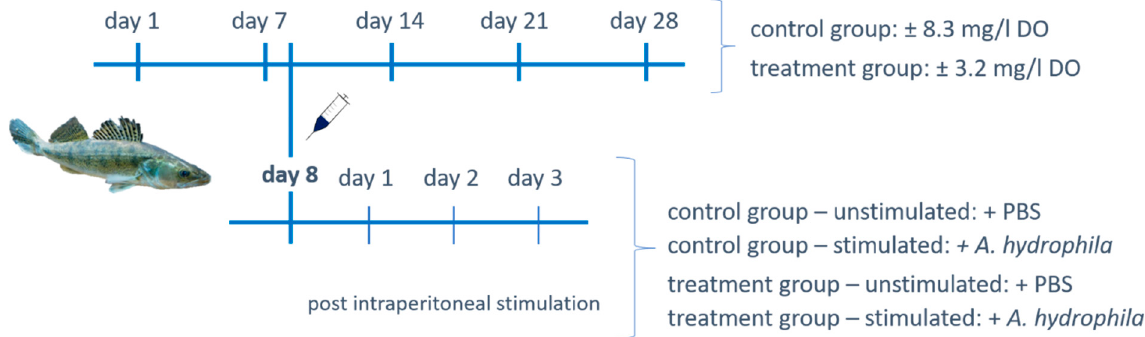
Figure 1. Outline of the experimental design. The 98 adult pikeperch were kept either under normoxic water conditions (±8.3 mg/L dissolved oxygen (DO) level) or low DO saturation (±3.2 mg/L DO level) for up to 28 days. Peripheral blood, head kidney (HK) and liver tissues were sampled from five fish of both groups. Additionally, at day 8 of the experiment, 48 fish were intraperitoneally injected with either 1 × 10 7 inactivated Aeromonas hydrophila cells in 100 µL sterile phosphate-buffered saline solution (PBS) or exclusively 100 µL PBS. At three following days, peritoneal leukocytes, peripheral blood, HK and spleen were collected from four fish per group.